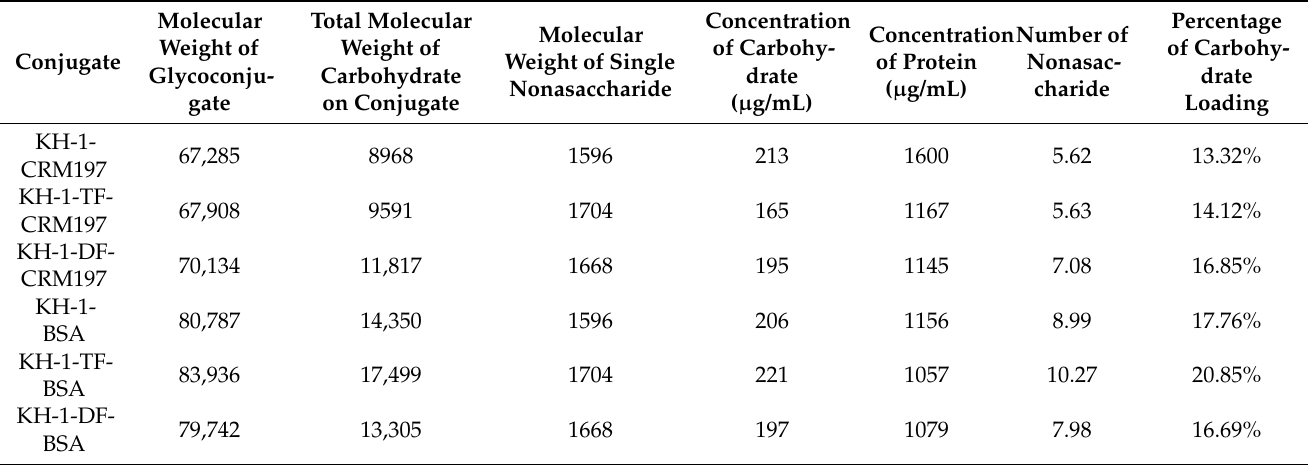
Table 1. Carbohydrate loading levels of glycoconjugates.